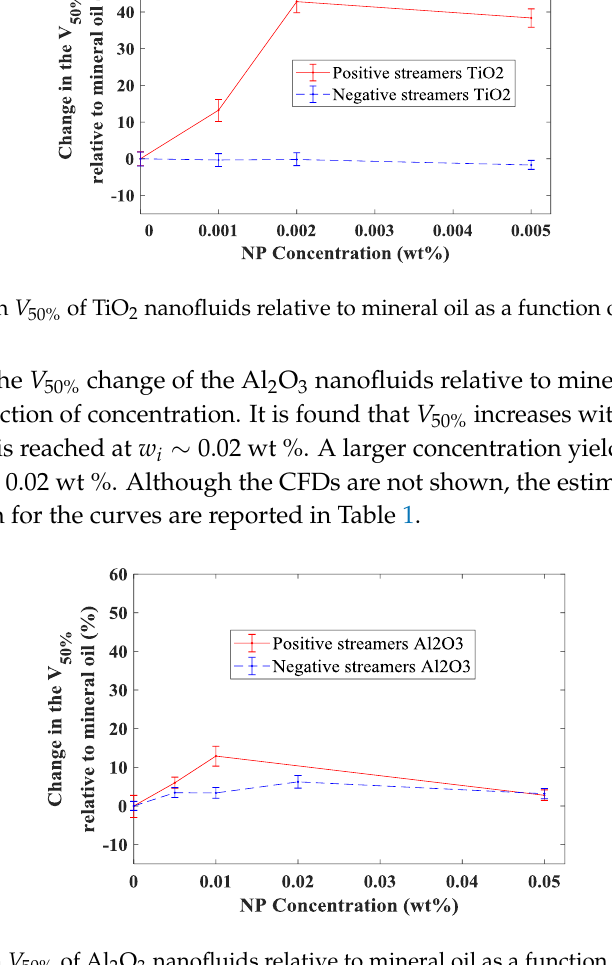
Figure 7. Change in 𝑉 50% of Al 2 O 3 nanofluids relative to mineral oil as a function of mass fraction 𝑤 𝑖 .